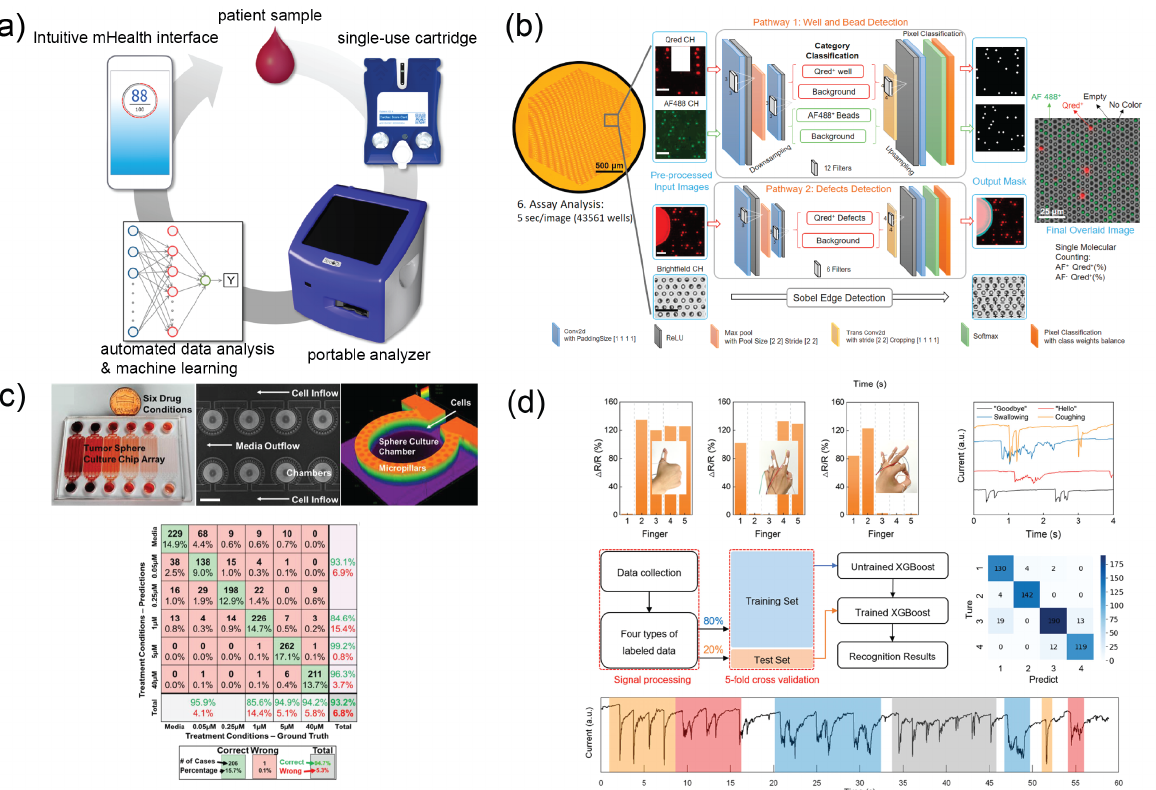
Figure 4. Micro- total analysis systems integrated with machine learning for clinical